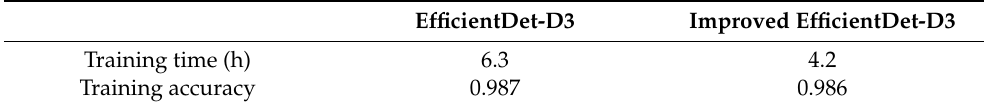
Table 3. Training time and accuracy of the two methods.